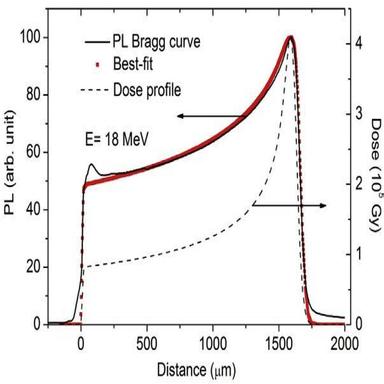
PL Bragg curve profile of the selected r.o.i. of with its best fit and dose profile obtained by the procedure described in the text.